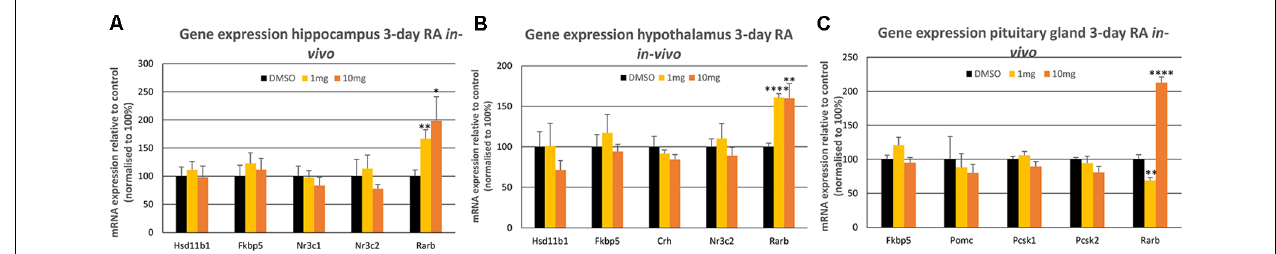
FIGURE 1 | The influence of 3-day 1 mg/kg or 10 mg/kg retinoic acid (RA) treatment of the rat on mRNA expression levels in the (A) hippocampus, (B) hypothalamus and (C) pituitary gland. The Rarb positive control was the only gene to show a statistically significant change in the three tissues ( p < 0.001 in all cases) indicated by ∗ . All control values were normalized to 100%. Panel A ; n = 6 RA, n = 6 control; panel B ; n = 6 RA, n = 6 control and panel C ; n = 5 RA, n = 5 control. ∗ = p < 0.05 , ∗∗ = p < 0.01, ∗∗∗∗ = p <